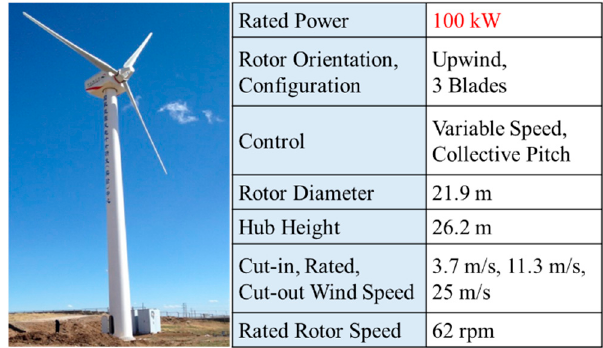
Figure 2. Photo and parameters of the 100 kW wind turbine.